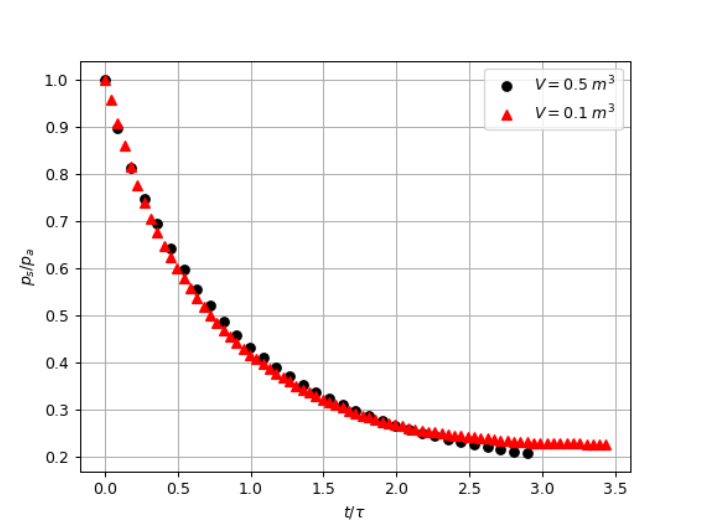
Figure 6. Experimental normalised pressure decay for both large and small vessel volumes.